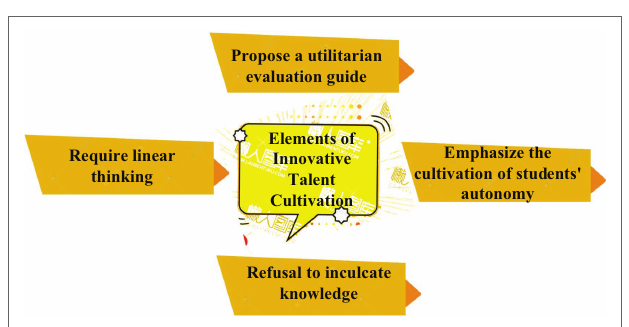
FIGURE 4 | Four elements of talent training.